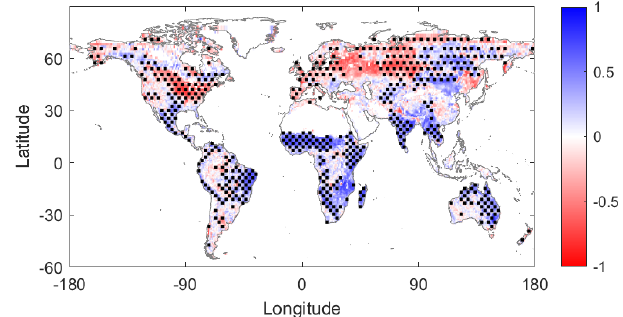
Figure 3. TROPOMI sun-induced chlorophyll fluorescence (SIF) and MERRA-2 photosynthetically active radiation (PAR) growing- season correlation. Same conventions as Fig.